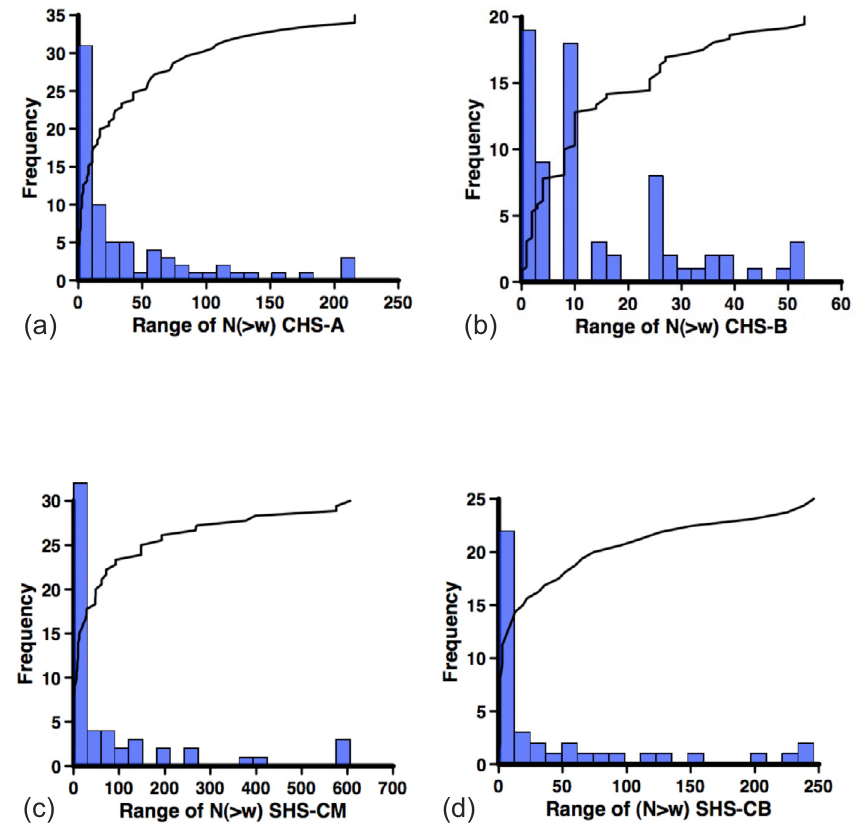
Figure 4. Histograms and cumulative curves (black solid lines) for the measured vein thickness. (a) Thickness distribution for CHS-A. (b) Thickness distribution for CHS-B. (c) Thickness distribution for SHS-CM. (d) Thickness distribution for